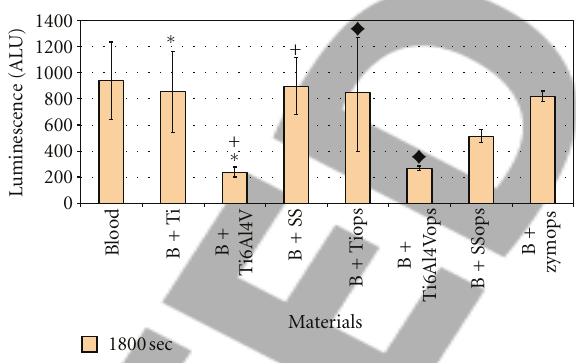
Figure 4: ROS production during whole blood cell interac- tions to opsonised and nonopsonised particulate materials before fMLP+PMA injection and at 1800 sec of chemiluminescence mea- surement (reaction mixture included whole blood cells without particulate materials, whole blood cells in the presence of Ti, Ti6Al4V, SS, Tiops, Ti6Al4Vops, SSops, and Zymops particles) ( ∗ , +, (cid:2) P < 0 . 05).